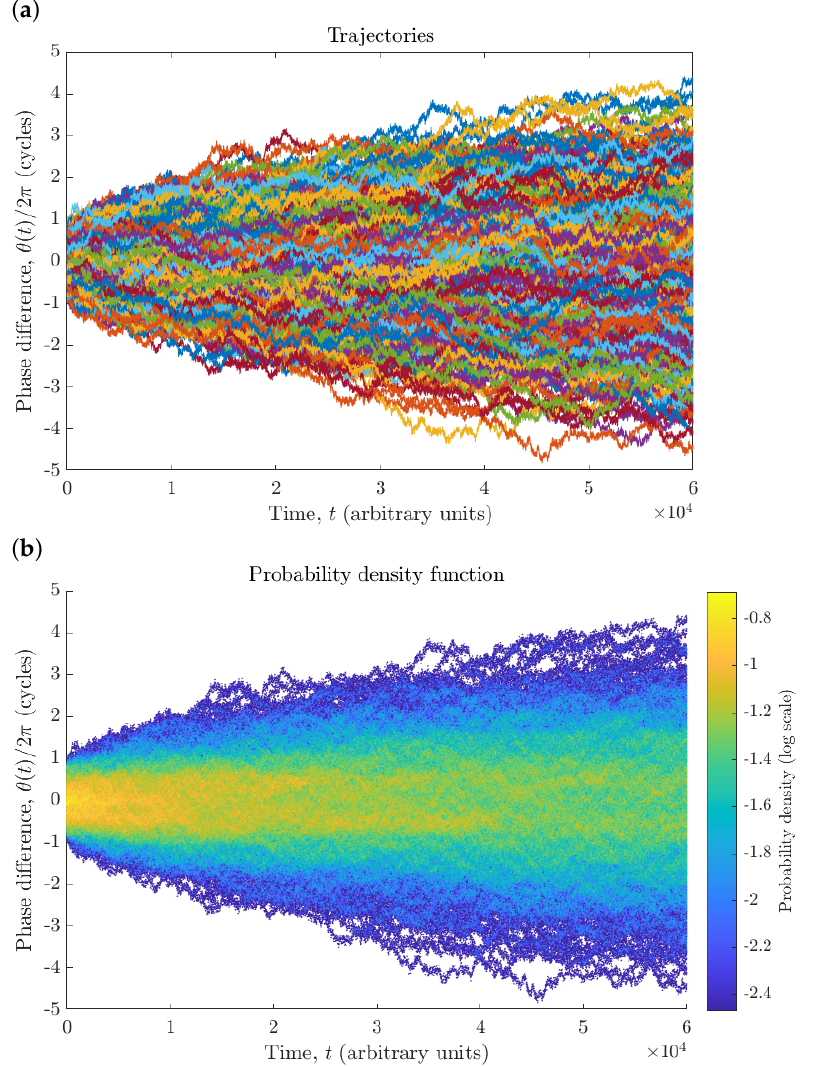
Figure 2. ( a ) Deterministic trajectories of phase difference θ ( t ) for random initial conditions and ( b ) corresponding probability density function, for coupling strength κ = 0. For weakly coupled oscillators, when the coupling strength is below the phase syn- chronization threshold ( κ < κ th ), all phase difference trajectories gradually increase in time regardless of initial conditions, as seen from Figure 3a. At the same time, the PDF reveals intermittent phase locking, represented by high probability bands, multiples of 2 π (Figure 3b). This phenomenon is detected for all values of the coupling strength below the phase synchronization